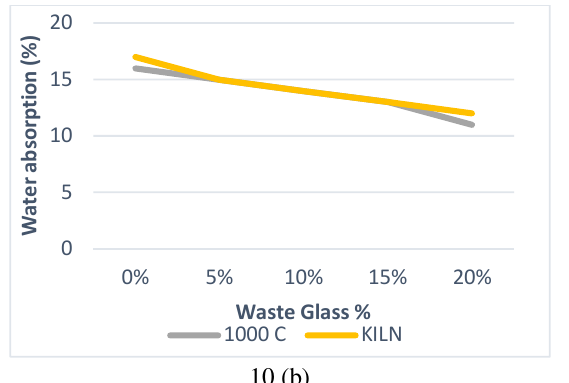
Fig. 10: Percent of waste glass added vs. water absorption at different temperatures